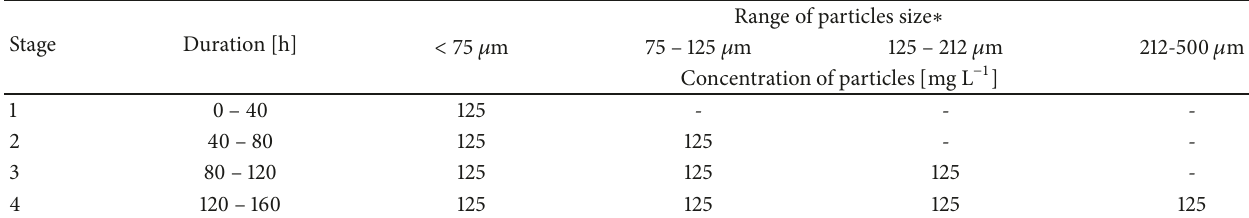
Table 2: Size and concentration of particles in each testing